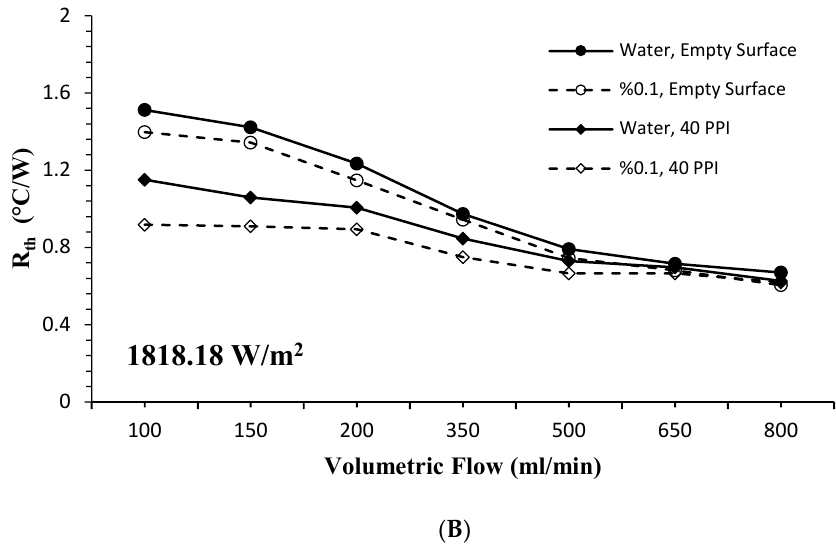
Figure 10. At 1818.18 W/m 2 constant heat flux, thermal performance variation with volume flow rate ( A ) 10 PPI; ( B ) 40 PPI.